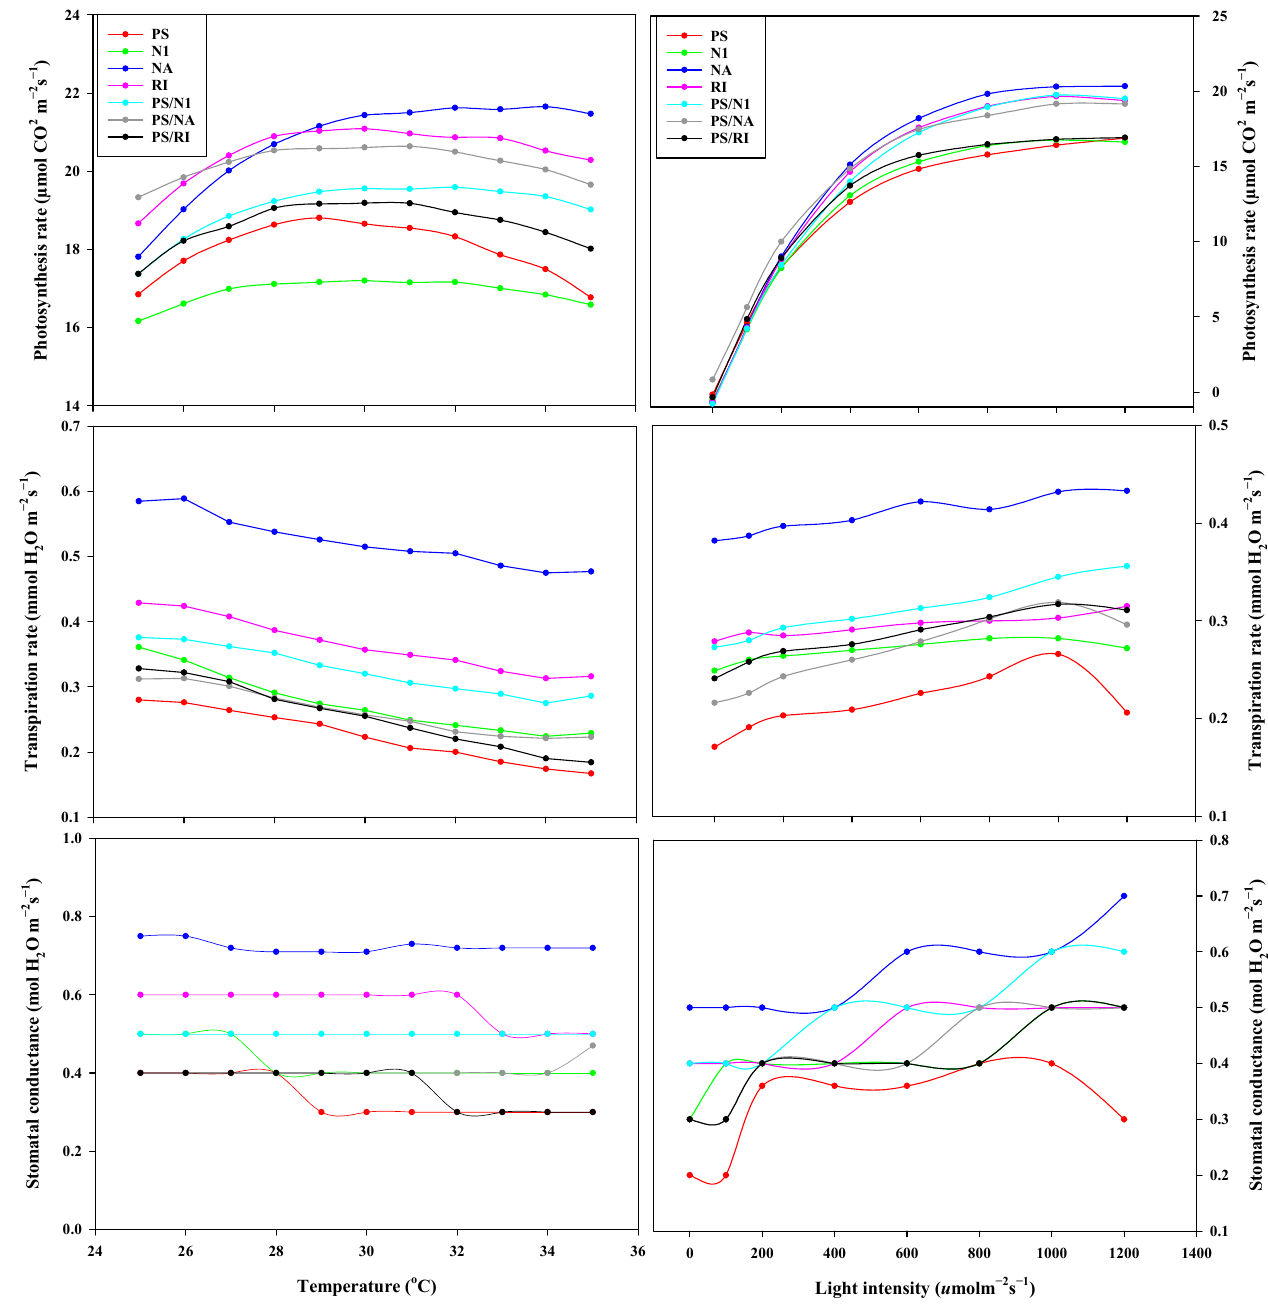
Figure 5. Photosynthetic parameters of one scion, three rootstocks, and three grafted cut rose flowers under different light and temperature conditions. PS: scion plant of spray rose Rosa hybrida cv. Pink Shine; N1: rootstock of Rosa multiflora cv. Hort No. 1; NA: rootstock of Rosa canina cv. Natal Briar; RI: rootstock of Rosa indica cv. Major; PS/N1: PS grafted onto N1; PS/NA: PS grafted onto NA; PS/RI: PS grafted onto